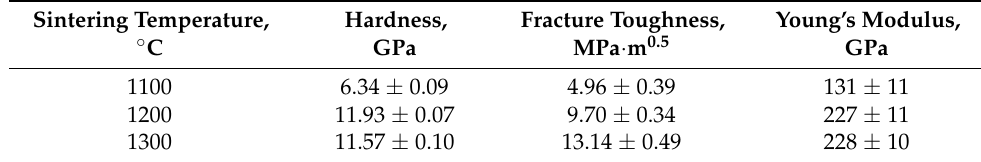
Table 3. Mechanical characteristics of a 2-wt% CaO-ZrO 2 ceramic of a baddeleyite origin sintered at different